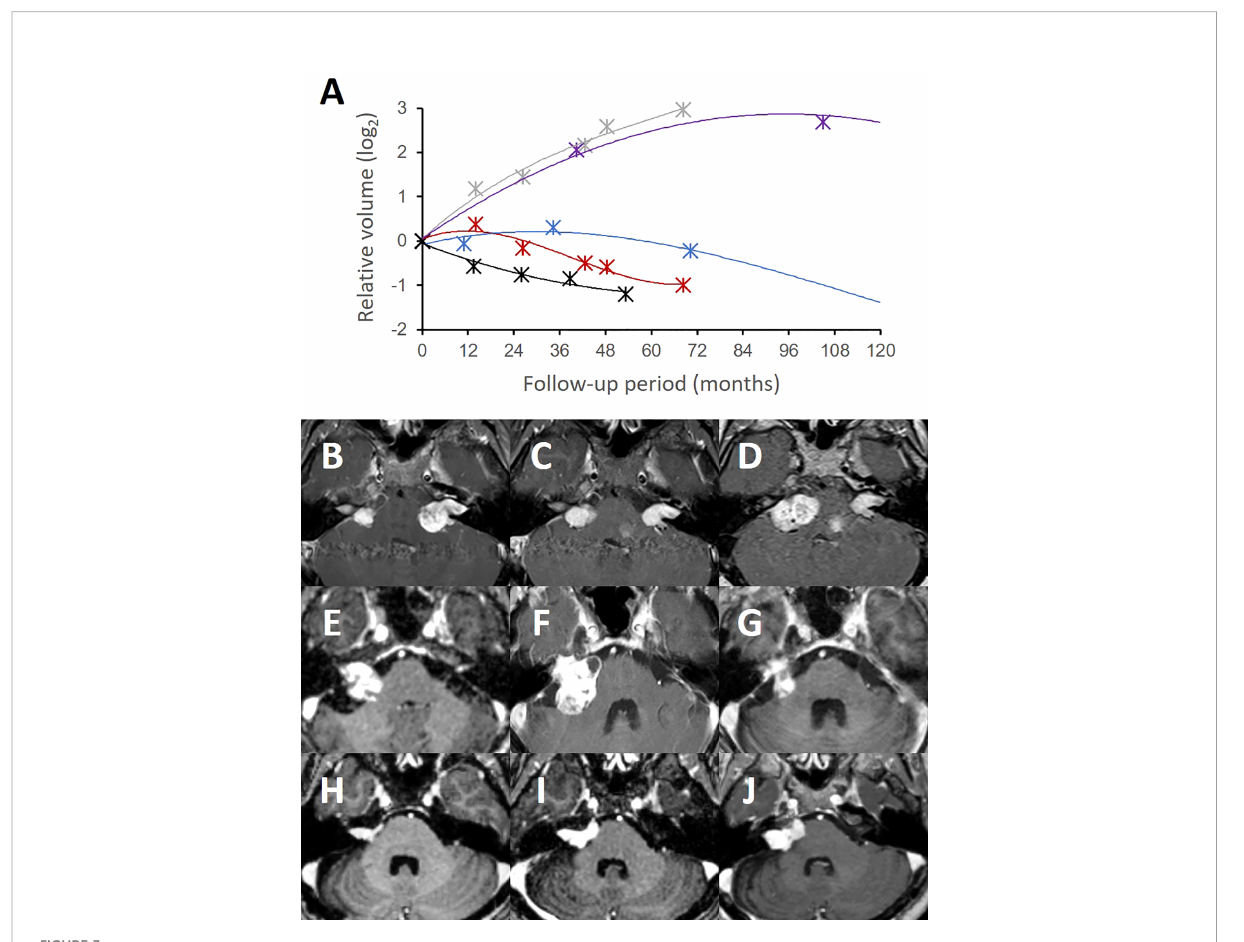
FIGURE 3 Tumor volume response patterns following stereotactic radiosurgery.The tumor volumes of the treated lesions showed distinct patterns in several treatment response groups (A) . Group I (black) refers to a typical volume response to SRS without signi fi cant pseudoprogression. Group II (red) volume responses had early pseudoprogression on the treated side compared to the contralateral untreated side (grey). Group III (blue) showed a slower response to SRS with delayed pseudoprogression. Group IV (purple) showed a failed tumor control with an exponential tumor growth pattern that was similar to untreated lesions (grey). A group I bilateral NF2-associated VS (B – D) showed favorable tumor control on the treated side (left). Notably, however, the contralateral untreated lesion (right) rapidly grew during the same follow-up period. A group III case (E) exhibited a slow treatment response, but successful tumor control over a long-term follow-up. This tumor had delayed pseudoprogression (F) up to three years post-treatment but eventually regressed without further treatment at 10 years (G) . A group IV case (H) was resistant to the SRS treatment and consistently grew over three years (I) and thereafter (J)